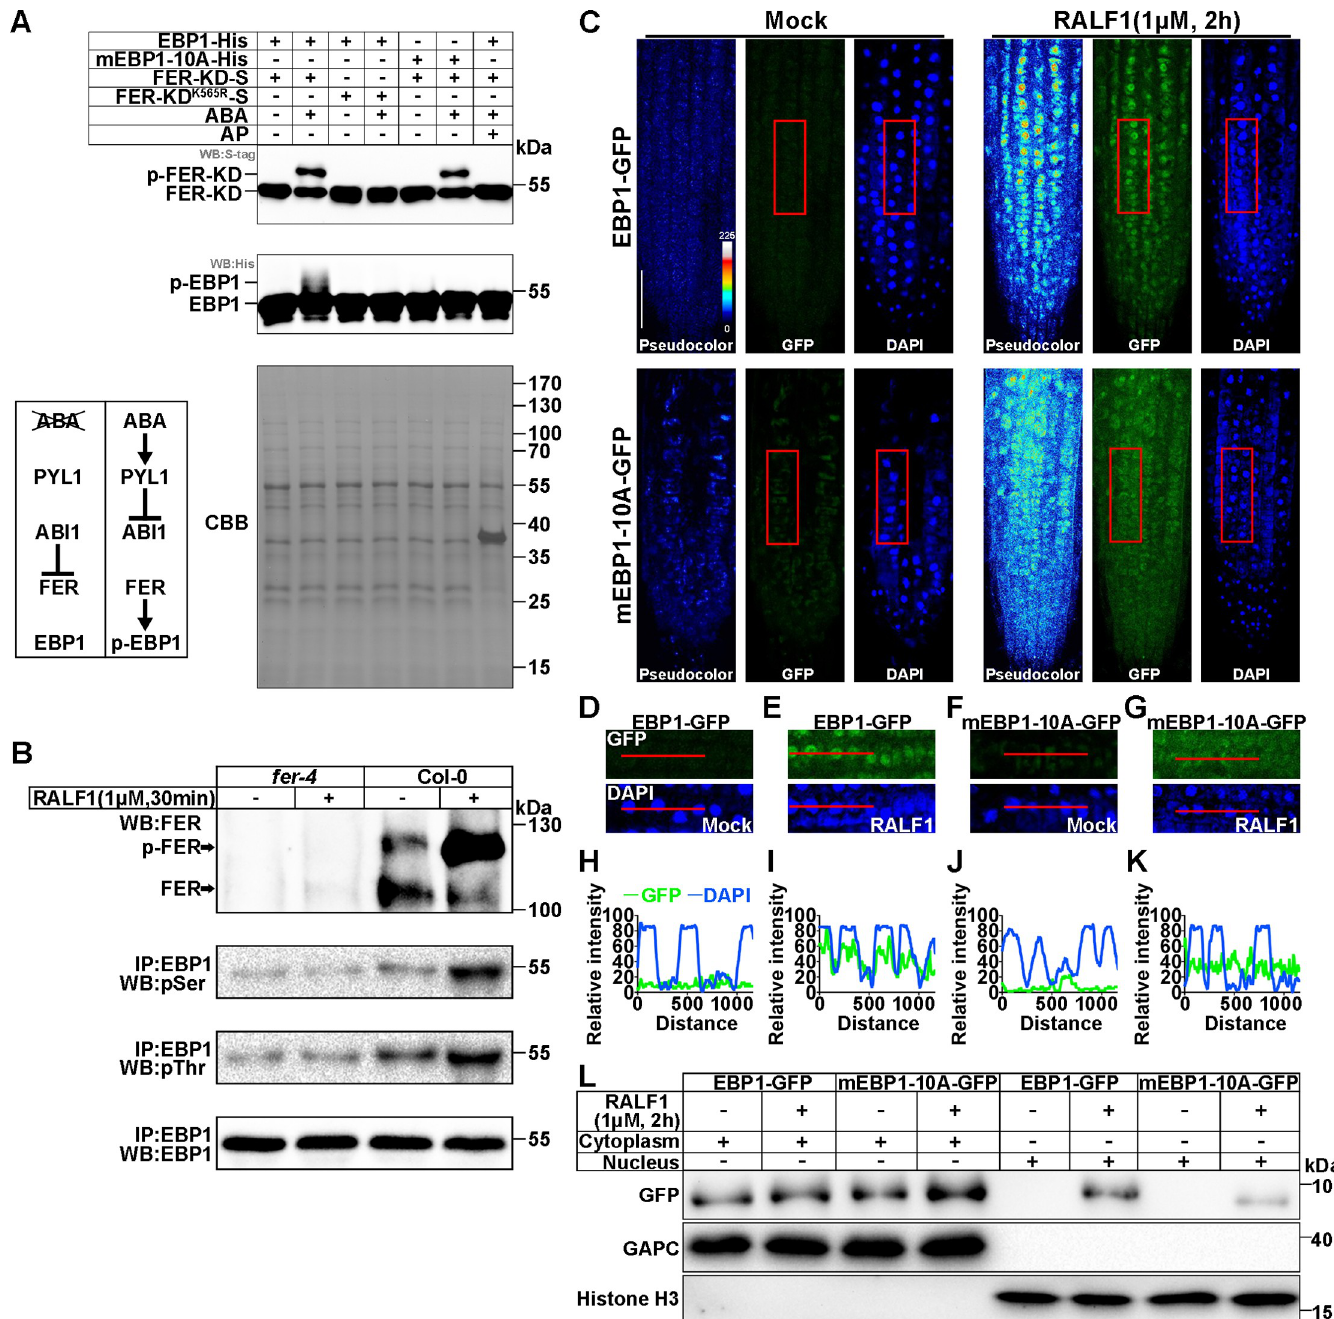
Fig 3. EBP1 nucleus accumulation and phosphorylation in response to RALF1-FER signaling pathway. (A) In vitro phosphorylation assay of EBP1. The phosphorylated and dephosphorylated FER-KD-S and EBP1-His are indicated. Anti-S-tag was used to detect FER-KD-S. Anti-His was used to detect EBP1-His. CBB staining is displayed as loading control. The diagram shows the skeleton of an ABA-triggered phosphorylation system. (B) Phosphorylation assay of the IP EBP1. The phosphorylation level of FER is measured by the intensity of the phosphorylated and dephosphorylated FER bands detected with FER antibody. pSer and pThr antibodies were used to detect the phosphorylated EBP1. For RALF1 treatment, 4-week-old Col-0 and fer-4 plants were soaked in 1/2 MS liquid medium with or without 1 μ M RALF1 for 30 minutes. EBP1 antibody was used to indicate loading control. We adjusted the level of total EBP1 protein to be same so that the changes in phosphorylation level of EBP1 can be easily visible. Three independent experiments of (A) and (B) were performed, and similar results were obtained. (C) Subcellular localizations of EBP1-GFP and mEBP1-10A-GFP in the root tip. Pseudocolor images show the signal intensities of the GFP signal. Color code bar indicates the relative intensities. The original pictures of GFP and DAPI signals are shown. Seedlings (with or without 1 μ M RALF1 treatment for 2 hours) that were 7 DAG were used for observation. Bar = 50 μ m. Five independent assays were performed, and similar results were obtained. (D-G) Close-ups of the GFP and DAPI signals in C (with red